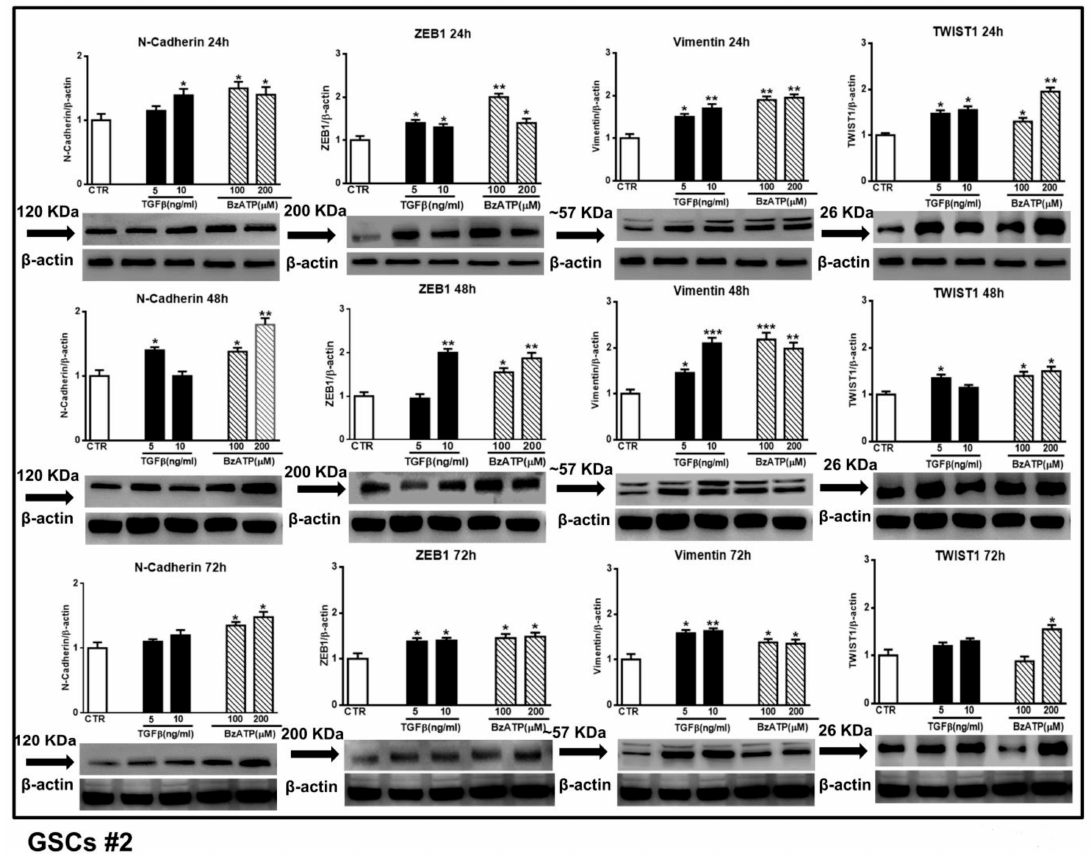
Figure 5. E ff ect of TGF β 1 or BzATP on EMT markers evaluated by western blot analysis at di ff erent times after drug administration to cultured GSCs #2. After exposure of the cells to di ff erent concentrations of TGF β 1 or BzATP, they were harvested at the indicated time periods. The protein levels of selected EMT markers were determined by western blot analysis. Immunoblots were obtained by exposing membranes to appropriate antibodies, recognizing proteins with di ff erent molecular weights (indicated close to the immunobands, over the arrows). Immunoblots were then re-probed with an antibody against β actin and quantified by densitometric analysis, the values of which, normalized to β actin used as an internal control, are reported in the histograms, assuming the value of control / β -actin = 1. Immunobands reported in the figure are representative of three independent experiments using the same cells. Also in this case, the bands of β -actin are the same for the blots related to the same time point, as they were obtained by cutting the same membrane at di ff erent heights corresponding to the molecular weights of the selected markers. * p < 0.05, ** p < 0.01, *** p < 0.001: statistical significance